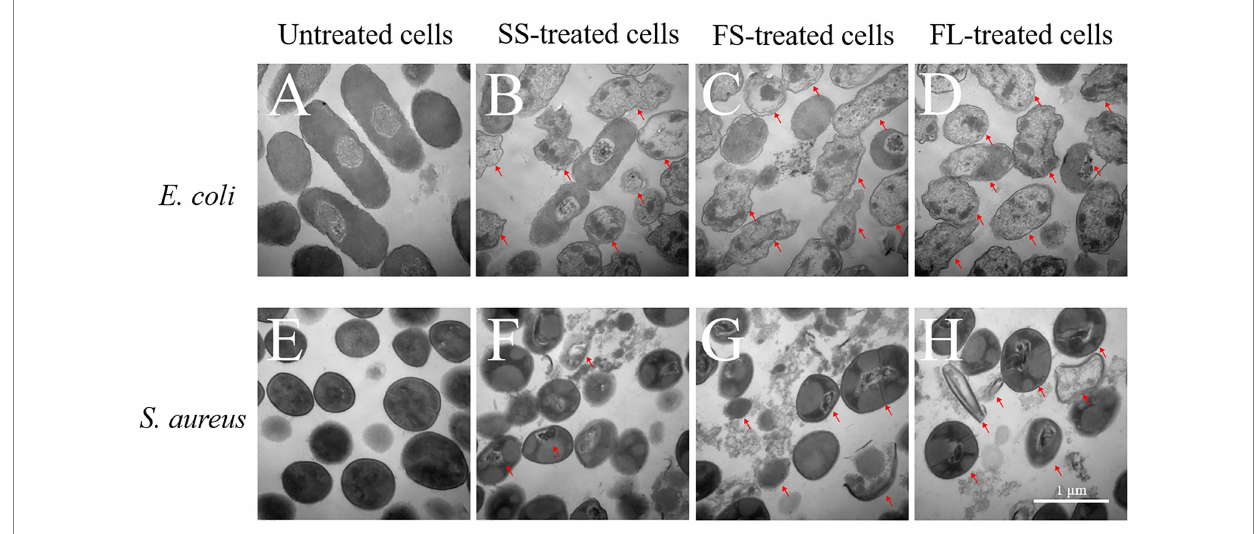
FIGURE 3 Transmission electron micrograph images of E. coli (40,000×, A–D ) and S. aureus (50,000×, E–H ) treated by high hydrostatic pressure (250 MPa/5 min and 450 MPa/5 min, respectively). (A,E) Control. (B,F) SS treatment. (C,G) FS treatment. (D,H) FL treatment. The arrows referred to the damaged